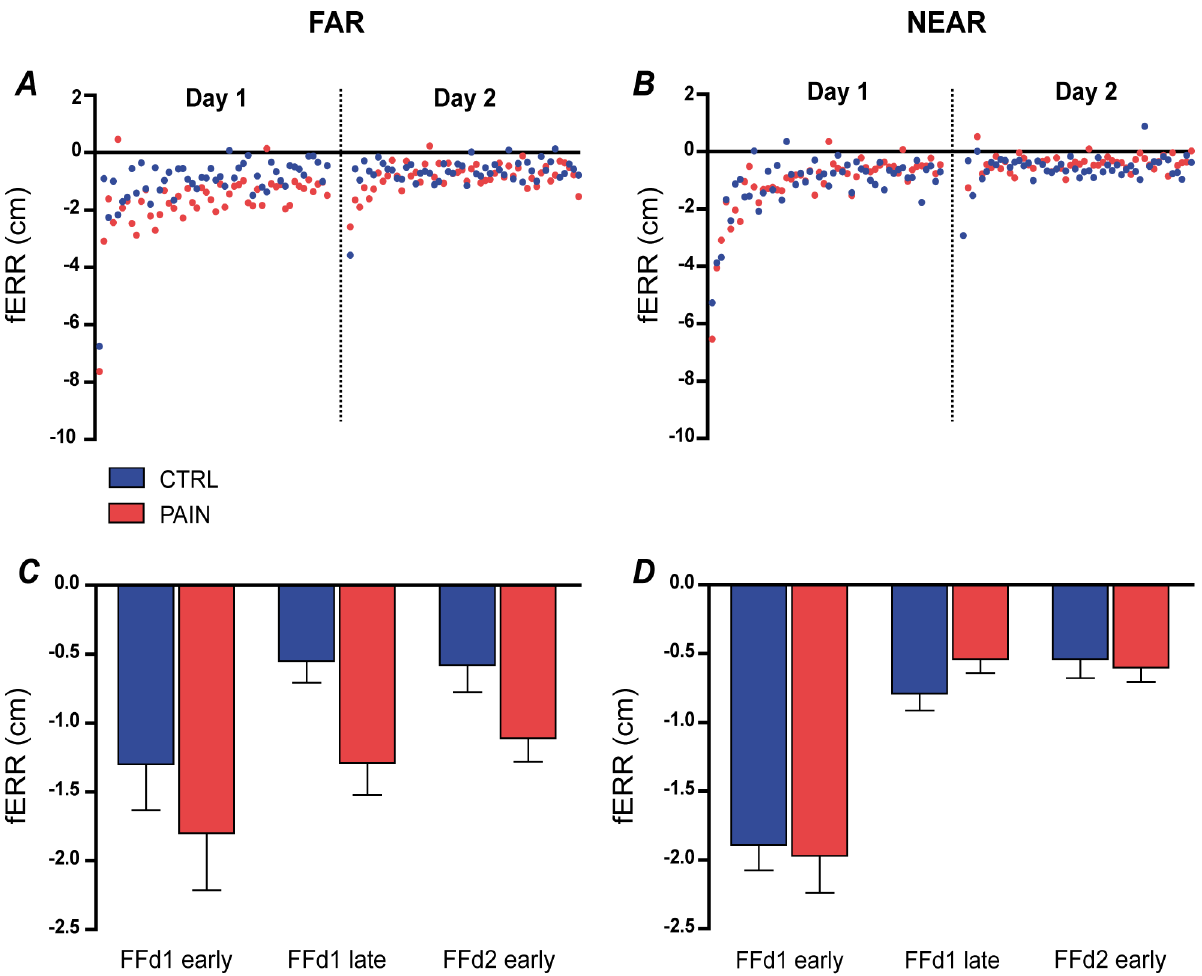
Figure 3. Changes in mean error (fERR) across time for each group. Panel A shows the time course for the FAR target, and Panel B for the NEAR target. Panels C and D show the average fERR for each group on sections of the time course selected for statistical analyses (Early/Late Day 1 and Late Day 2), respectively for FAR and NEAR target. Both groups improved their performance on Day 1, as illustrated by the rapid decay of fERR over trials. A strong Retention is demonstrated by a better performance on Early Day 2 compared to Early Day 1. However while both groups show very similar performance for the NEAR target, the Pain group systematically shows larger errors for the FAR target. This difference is still observed on Day 2, when all subjects are tested pain-free. Error bars show the standard error of mean